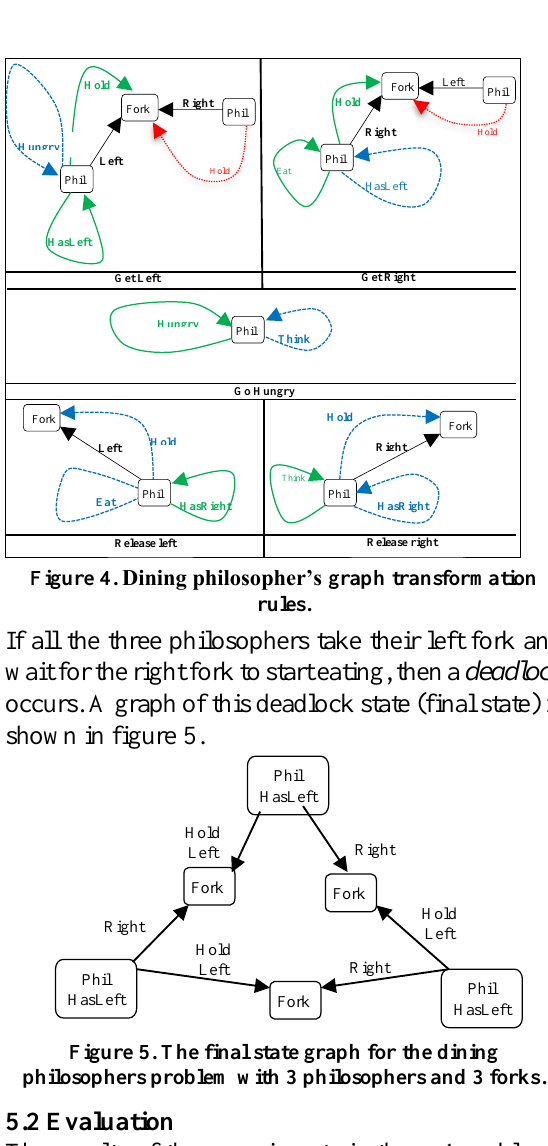
Figure 2. Type graph of the dining philosopher problem.